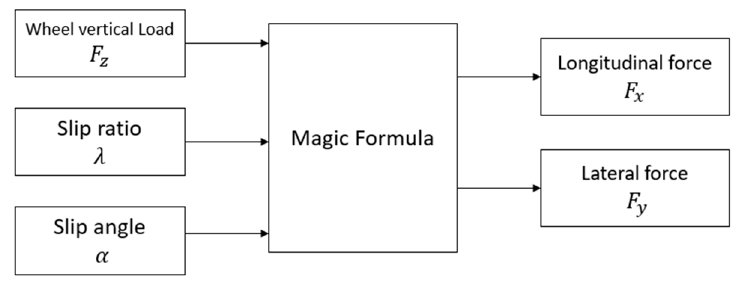
Figure 1. Magic Formula inputs and